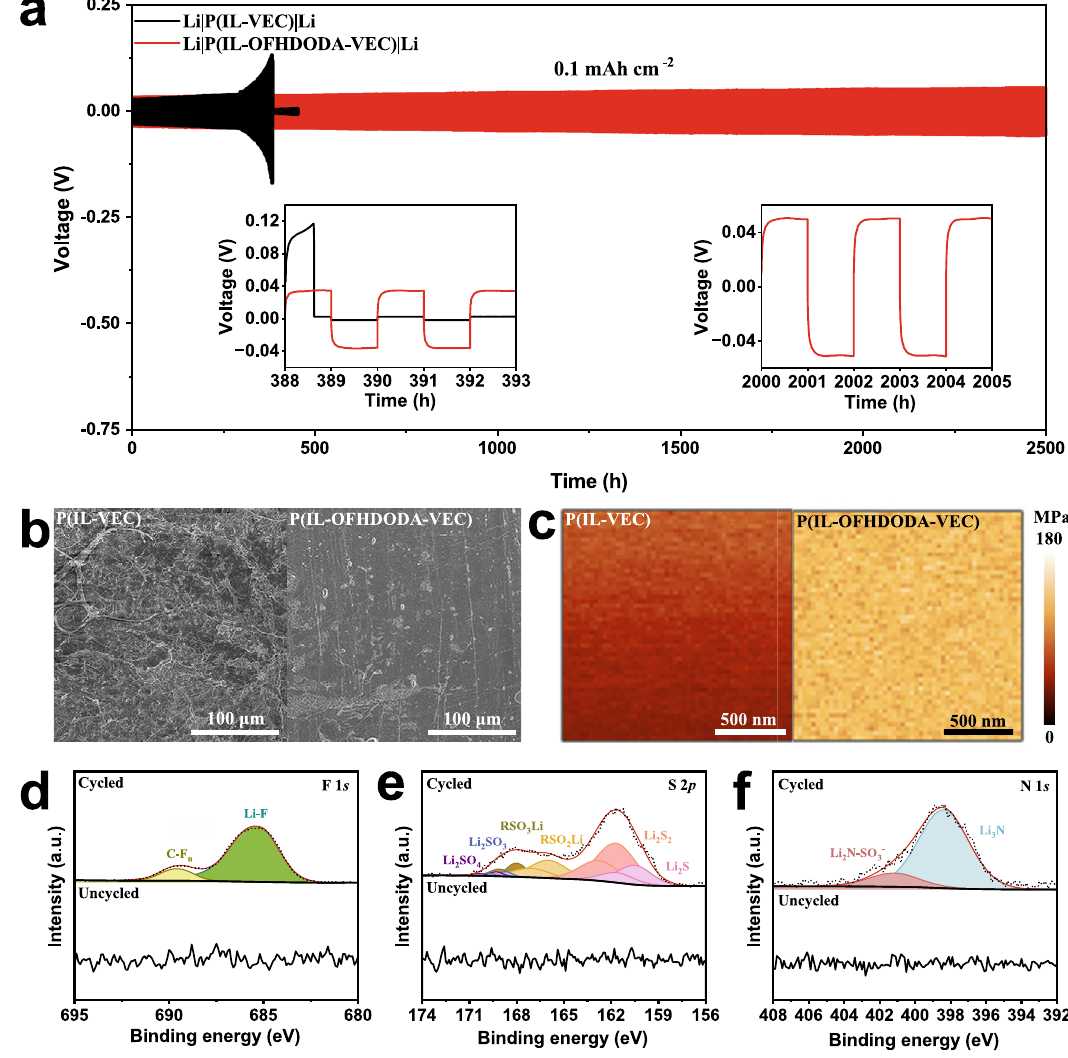
c Young ’ s modulus of P(IL-VEC) and P(IL-OFHDODA-VEC). d – f XPS analysis of F 1 s ( d ),S2 p ( e ),andN1 s ( f